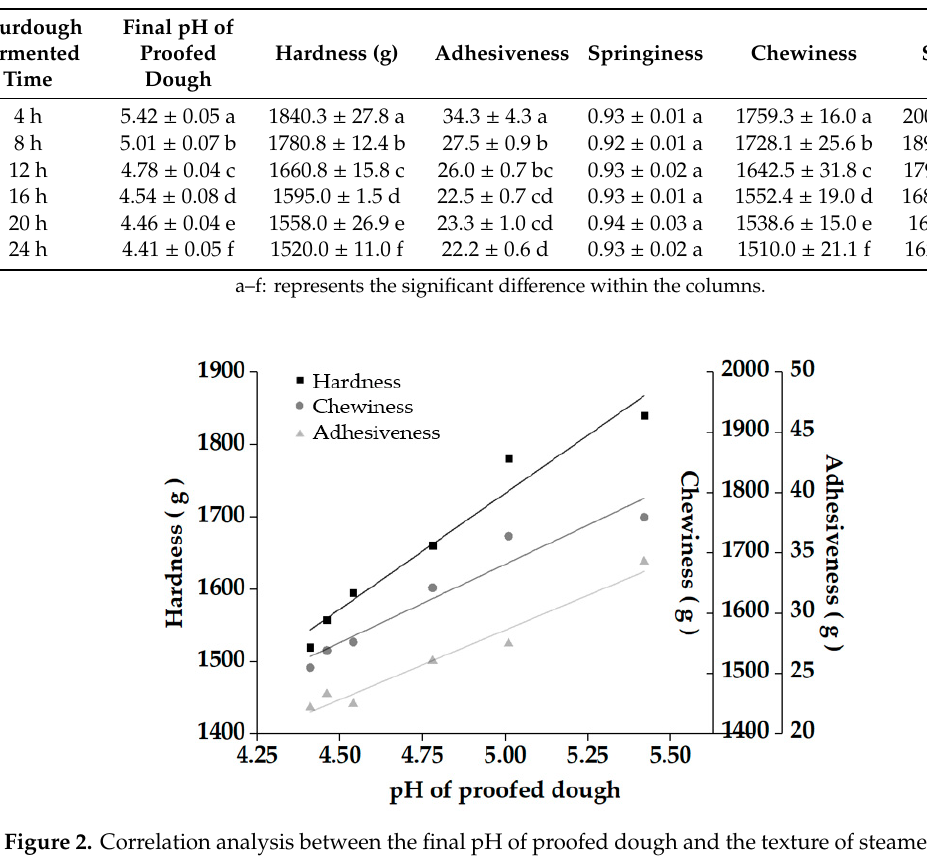
Figure 2. Correlation analysis between the final pH of proofed dough and the texture of steamed bread: R 2 = 0.95821 (hardness); R 2 = 0.93295 (chewiness); R 2 = 0.96348 (adhesiveness).